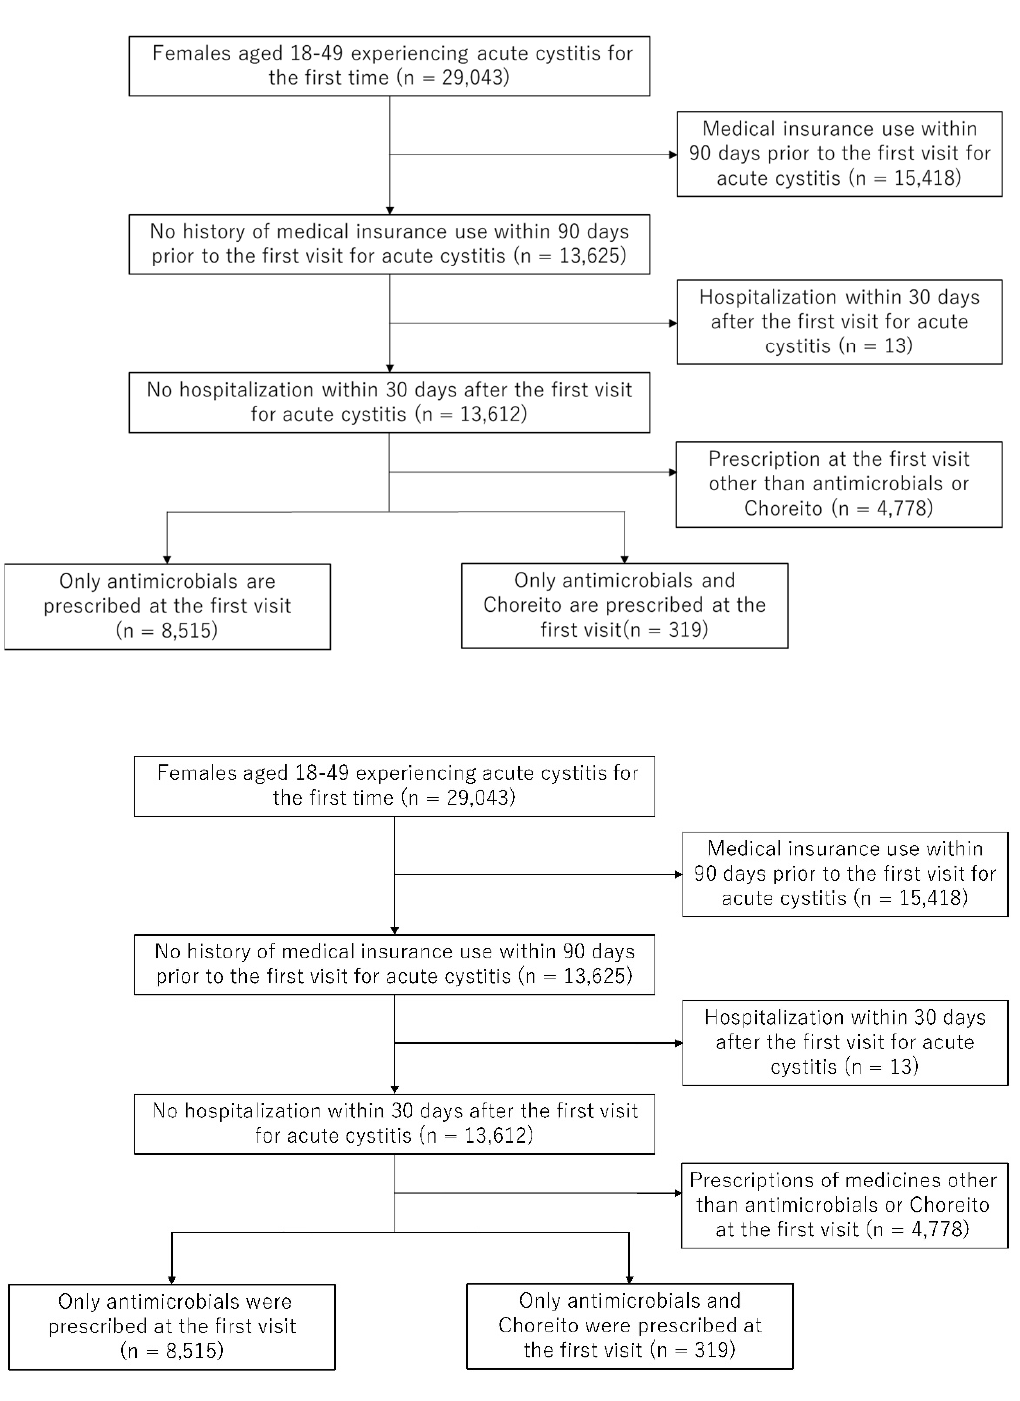
Figure 1. Flow chart outlining patient selection.